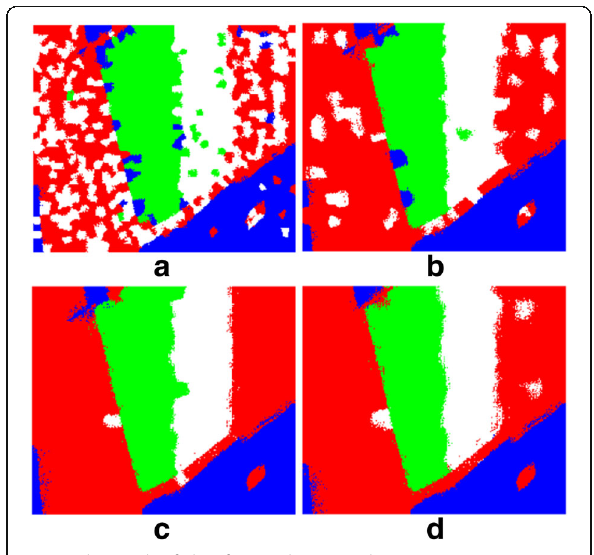
Fig. 7 The result of classification by using the majority voting principle in the superpixel blocks. a a = 7, p = 3. b a = 11, p = 5. c a = 14, p = 6. d a = 16, p =